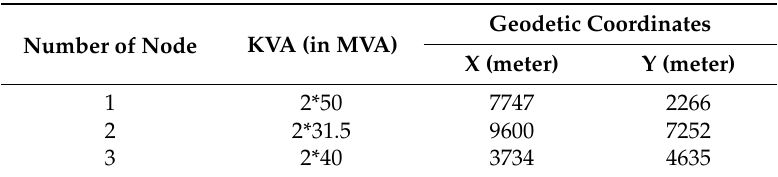
Table 3. The general situation of the power stations.